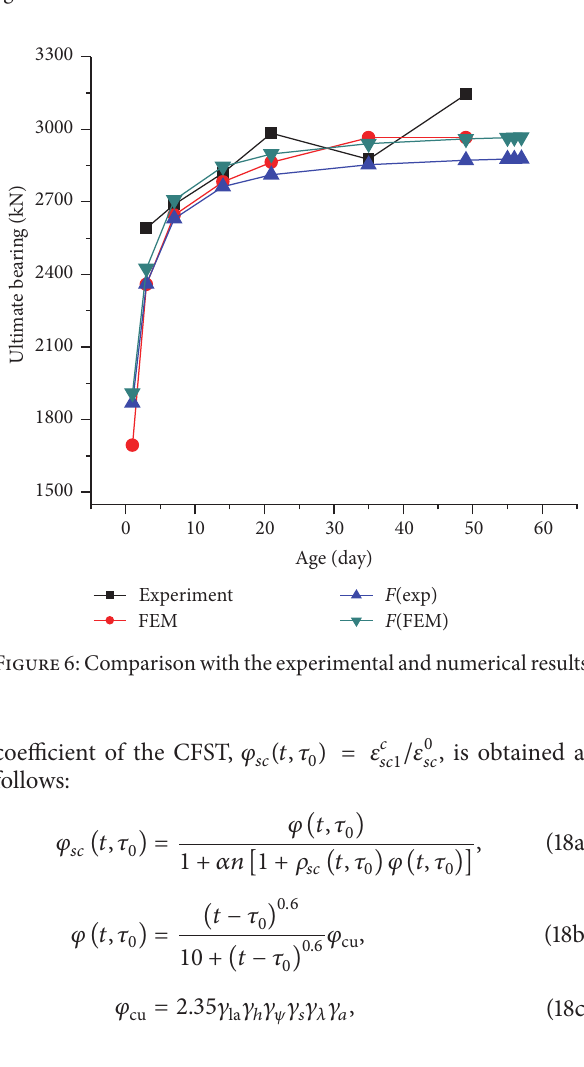
Figure 5: Load-bearing capacity of the CFST column at different ages.